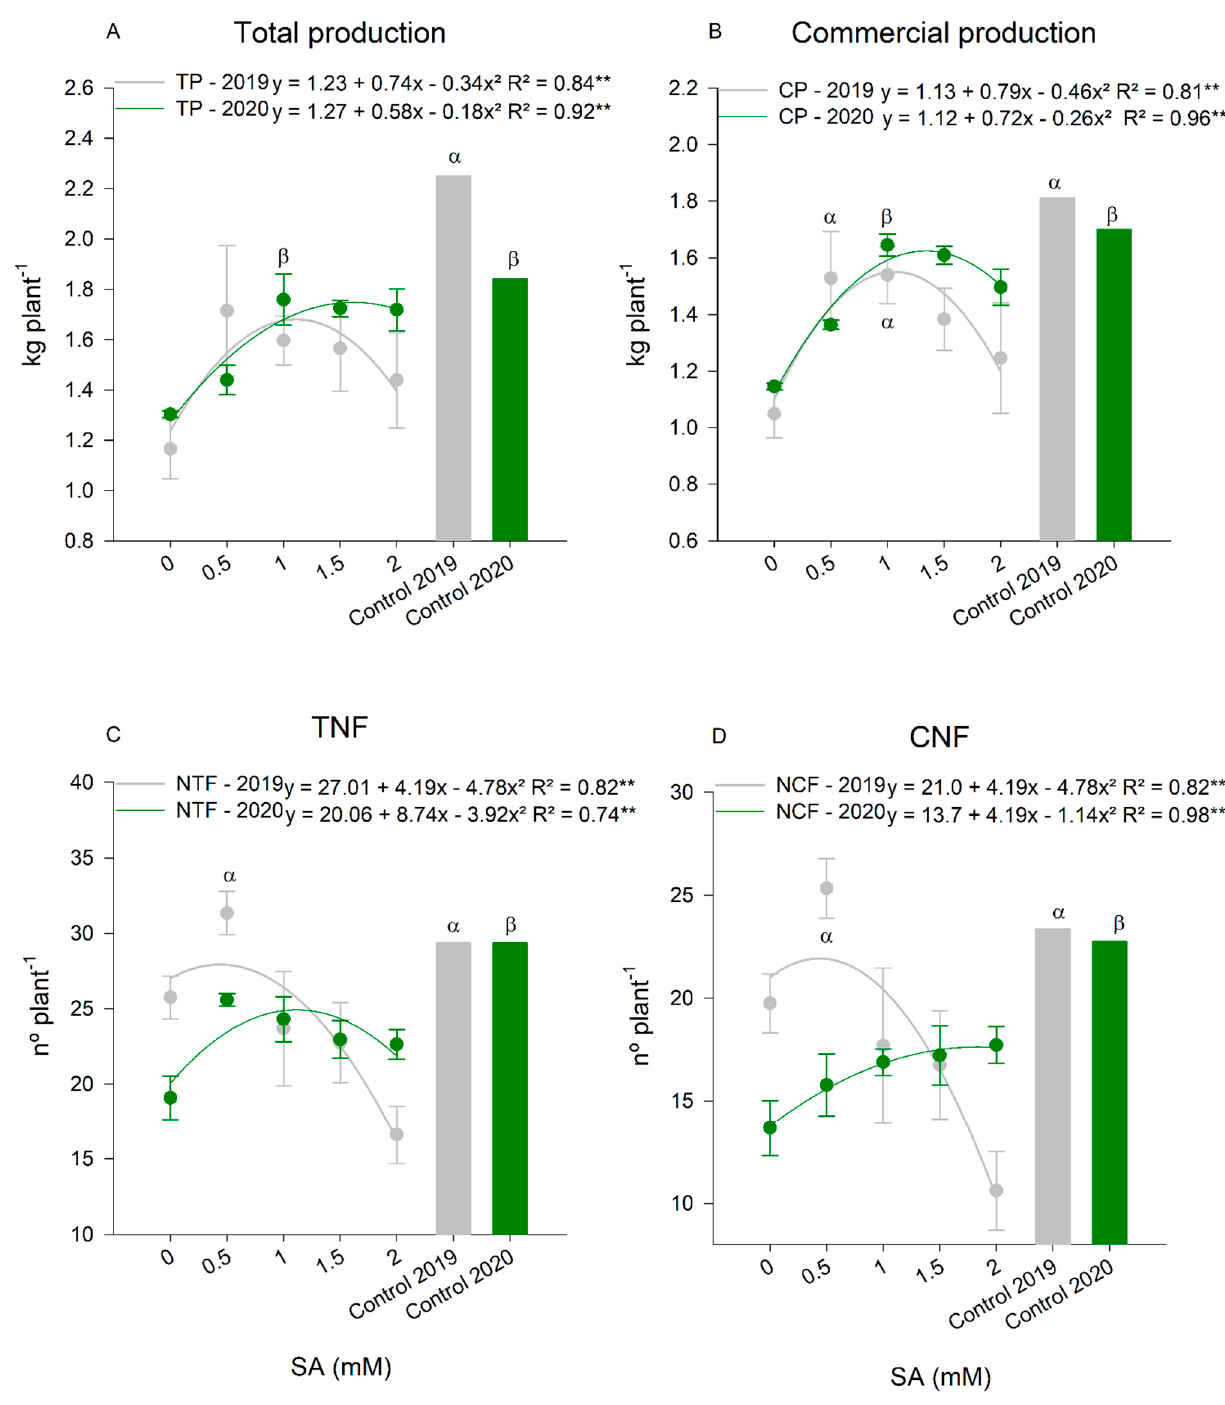
Figure 5. Total production ( A ), commercial production ( B ), total number of fruits (TNF) ( C ), and commercial number of fruits (CNF) ( D ) of tomato plants submitted to the application of doses of salicylic acid (SA) and water deficit in two consecutive years (2019 and 2020). ** Highly Significant at 5% probability; α Indicates that there was an equal and significant effect between treatments by the Dunnett’s Test at 5% probability in the 2019 cycle and β in the 2020 cycle. The bars show the standard deviation. n = 4 (number of replicates).